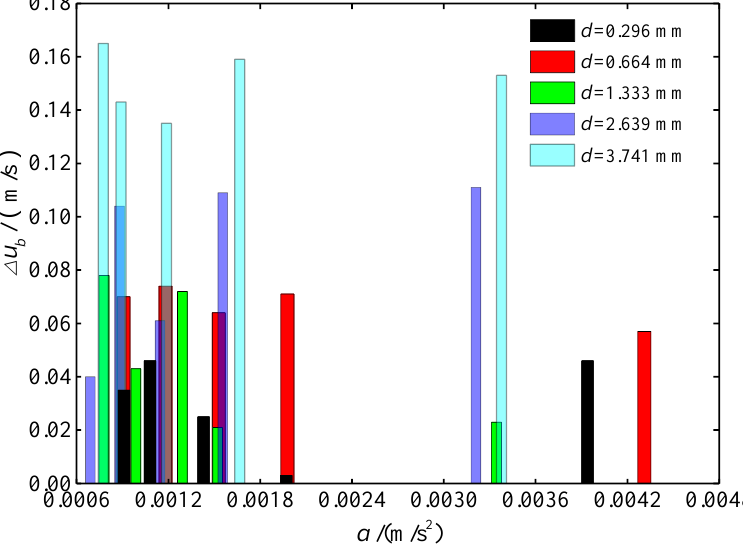
Figure 7. Velocity comparison between steady flow corresponding to the same transport rate as the unsteady flow and steady flow through integration.